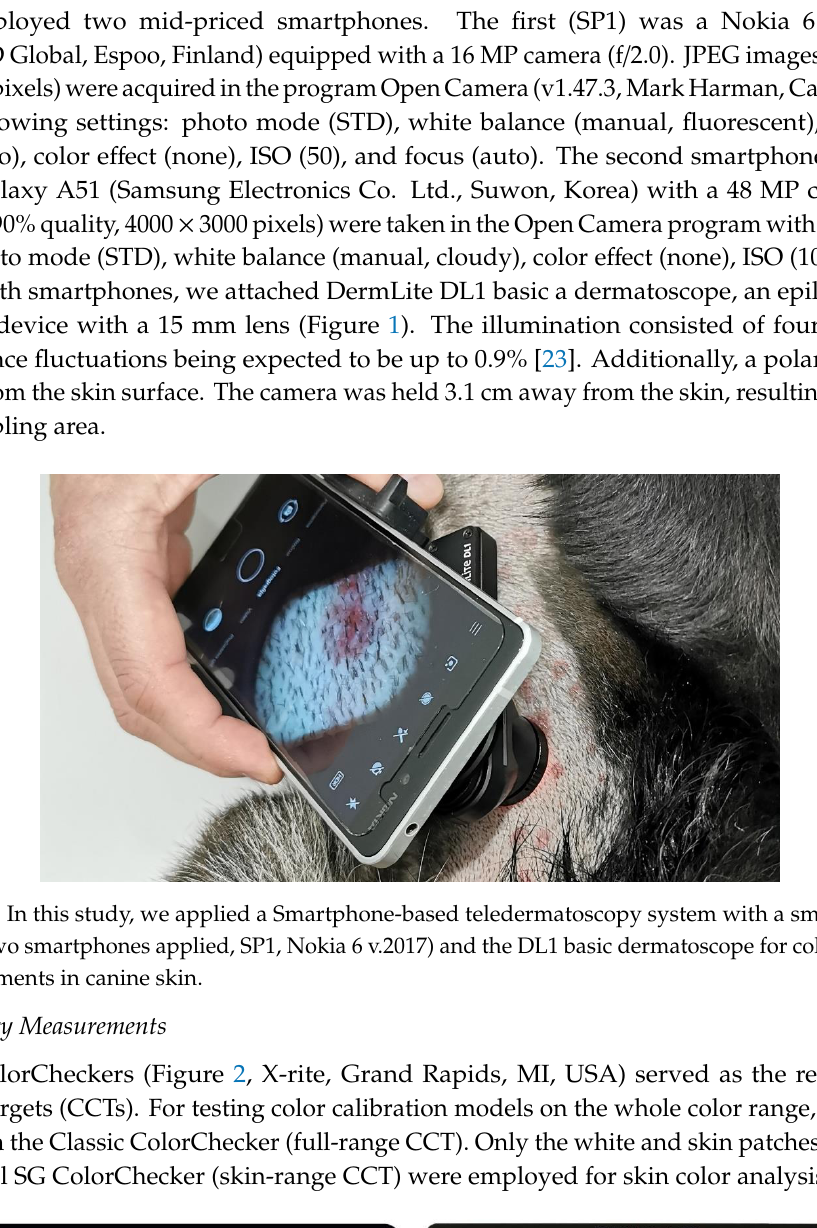
Figure 3. Flowcharts of different color calibration procedures. ( a ) Image sets ( I full/skin 1–6 ) of the selected CCT color patches were acquired and normalized against patches 19 (full-range CCT) or E5 (skin- range CCT). For each set independently, we built a transformation model between an unknown RGB and a standard CIELAB color space ( LAB = f ( RGB )). ( b ) Full normalization. RGB values of I 2–6 were first transformed to the RGB color space of I 1 and later to the CIELAB based on the known f 1 . ( c ) Single- point normalization. Normalized images ( I 2–6 ) with the brightest patch (No. 19) were directly transformed to the CIELAB color space based on the known f 1 . ( d ) Erythema Index (EI) was calculated after the colorimetric data was transformed to the standard RGB color space (sRGB). For each image set (Figure 3a), we then built a linear-regression model between an unknown device-dependent RGB and a device-independent CIELAB color space: LAB = f full/skin 1–6 ( RGB ). The mathematical model was based on the best performing polynomial from our previous study [23]: 𝐿𝐴𝐵 = 𝑎 0 + 𝑎 1 𝑅 + 𝑎 2 𝐺 + 𝑎 3 𝐵, {𝐿 ∗ ,𝑎 ∗ ,𝑏 ∗ } ∈ 𝐿𝐴𝐵 , (1) where L* (lightness), a* (green-red), and b* (blue-yellow) are coordinates of the CIELAB color space, and a 0–3 are regression coefficients, estimated with the function fitlm (Matlab, R2016a, MathWorks, Natick, MA, USA). The color difference ( ΔE , CIE76) was calculated from fitting residuals as a Euclidean distance between estimated and true color [17]: ∆𝐸 = √(∆𝐿 ∗ ) 2 + (∆𝑎 ∗ ) 2 + (∆𝑏 ∗ ) 2 . (2) CIE94′s ΔE was estimated with the openly available Matlab code [25]. Based on the full-range CCT, we additionally tested a few modified color calibration procedures, which could improve, deteriorate, simplify, or expedite clinical measurements: